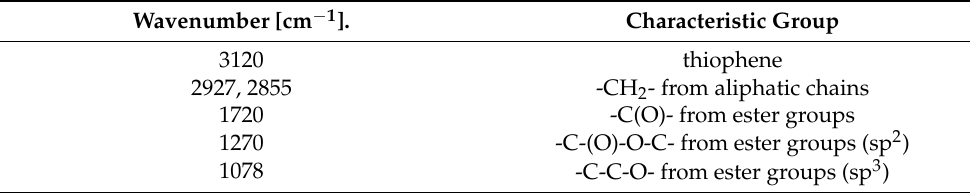
Table 2. Characteristic FTIR stretching signals in the